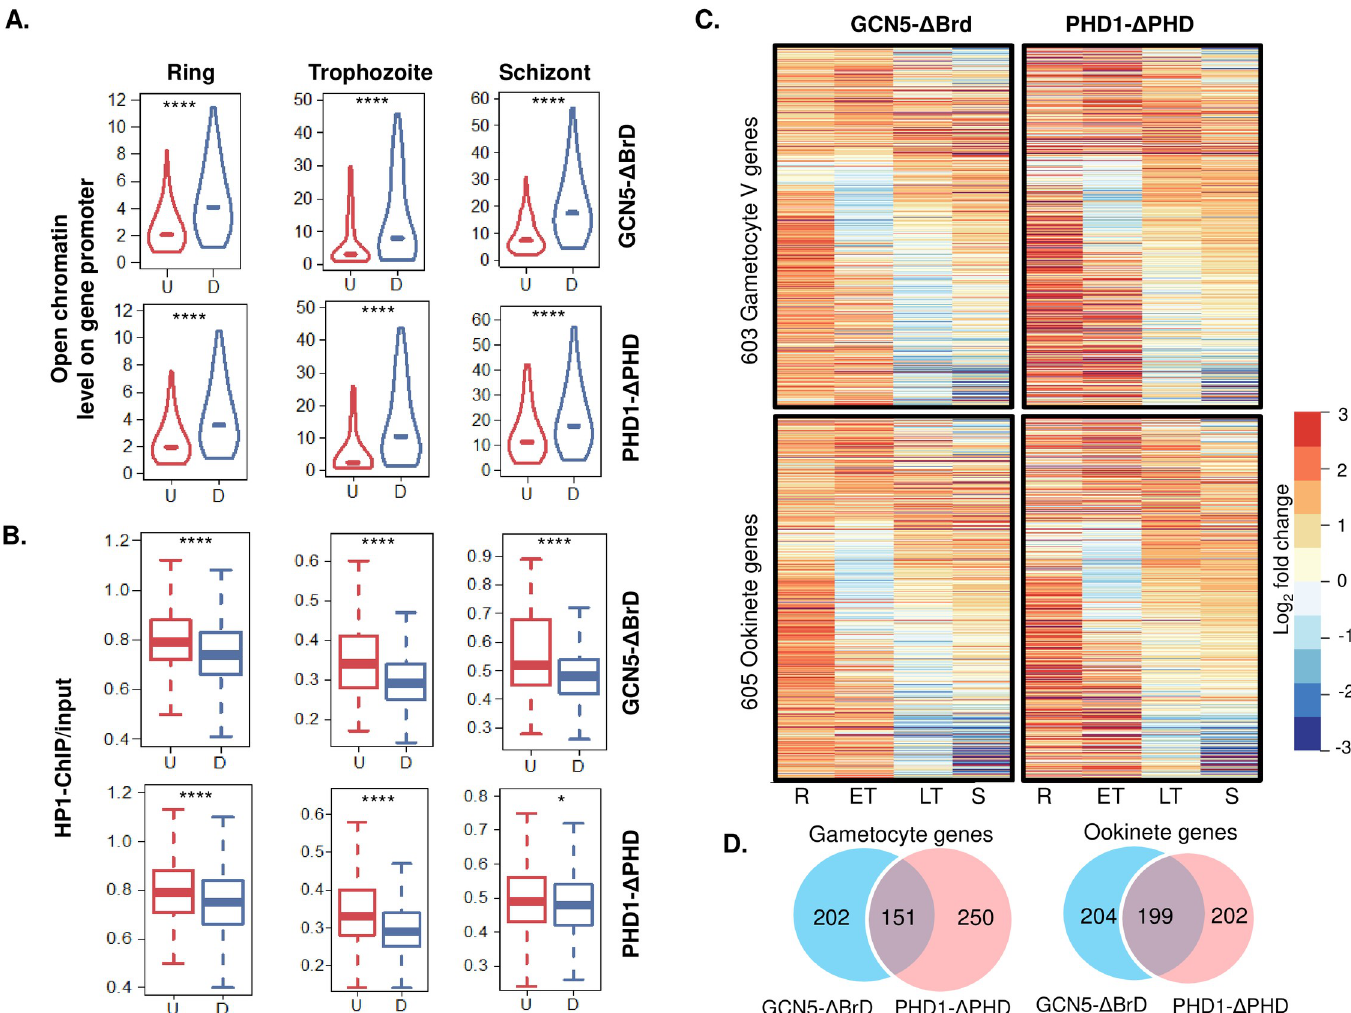
Fig 7. Correlation of genes showing altered expression in domain deletion mutants with promoter accessibility and chromatin states. (A, B) Changed levels of gene expression in PfGCN5- Δ Brd and PfPHD1- Δ PHD are negatively correlated with the accessibility of the promoters (from the ATAC-seq analysis, The y-axis shows that the ratio of ATAC-seq peak (scaled per million reads) vs genomic DNA library) (A), but are positively correlated with the heterochromatin state (represented by the HP1 occupancy) (B). U, upregulation; D, downregulation. � , P < 0.05; ���� , P < 0.0001 (Wilcoxon rank-sum test). (C) Heatmaps displaying the transcriptional activation of gametocyte and ookinete genes in the domain deletion mutants. R, ring; ET, early trophozoite; LT, late trophozoite; S, schizont. (D) Overlaps of activated gametocyte- or ookinete-specific genes between PfGCN5- Δ Brd and PfPHD1- Δ PHD.